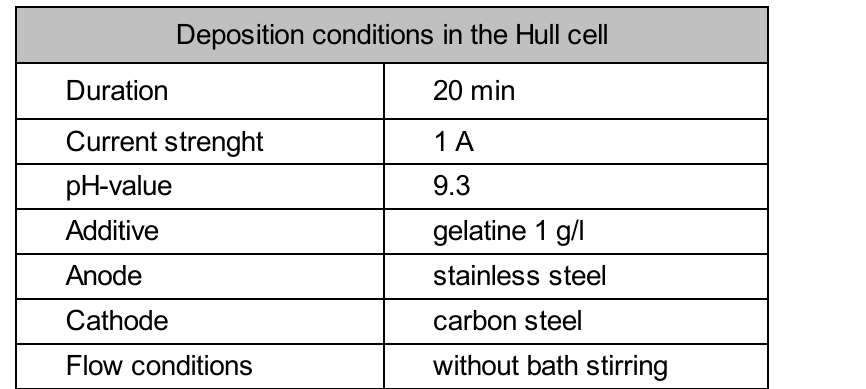
Table 2 – Electroplating parameters in the Hull cell Таблица 2 – Параметры гальванического покрытия в ячейке Хулла Tabela 2 – Parametri galvanizacije u Hulovoj ć